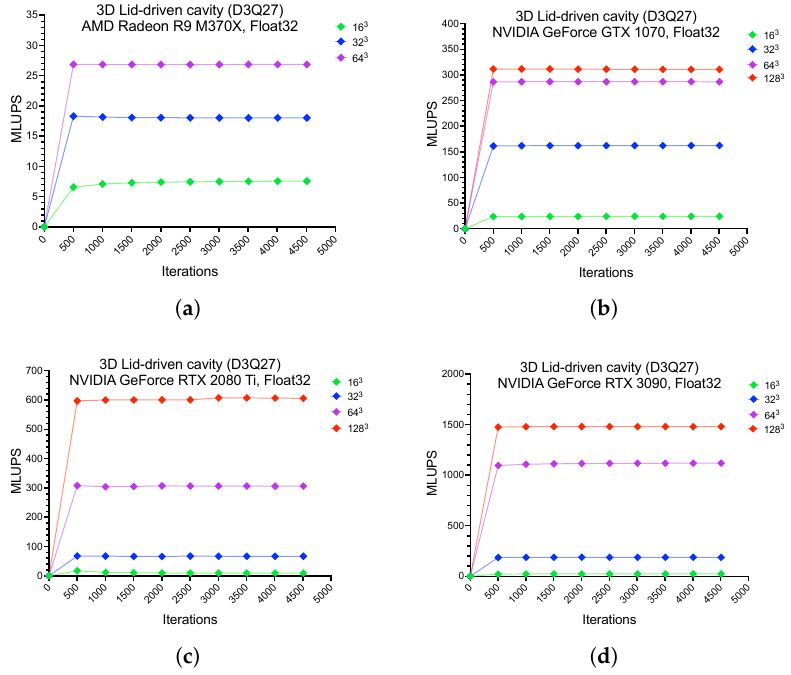
Figure 9. Single-precision performance analysis of 3D lid-driven cavity on D3Q27 stencil with multiple-relaxation time. ( a ) Performance on Radeon R9 M370X GPU; ( b ) Performance on GTX 1070 GPU; ( c ) Performance on RTX 2080 Ti GPU; ( d ) Performance on RTX 3090 GPU.